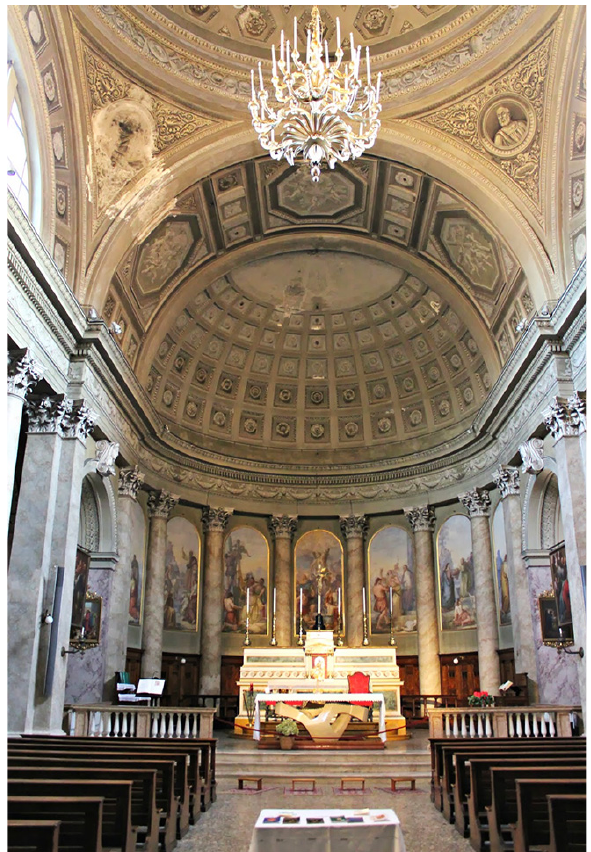
Figure 2. Interior view of the church of